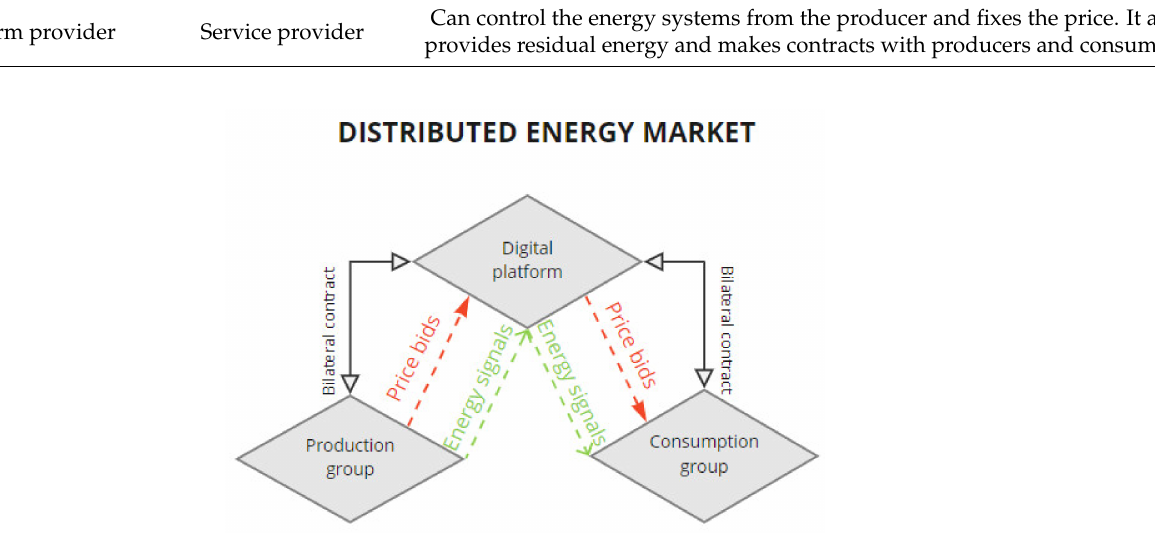
Figure 4. Actor roles sketch—distributed P2P-ET market. Sketch-based on own interpretation from Section 2.2.3.